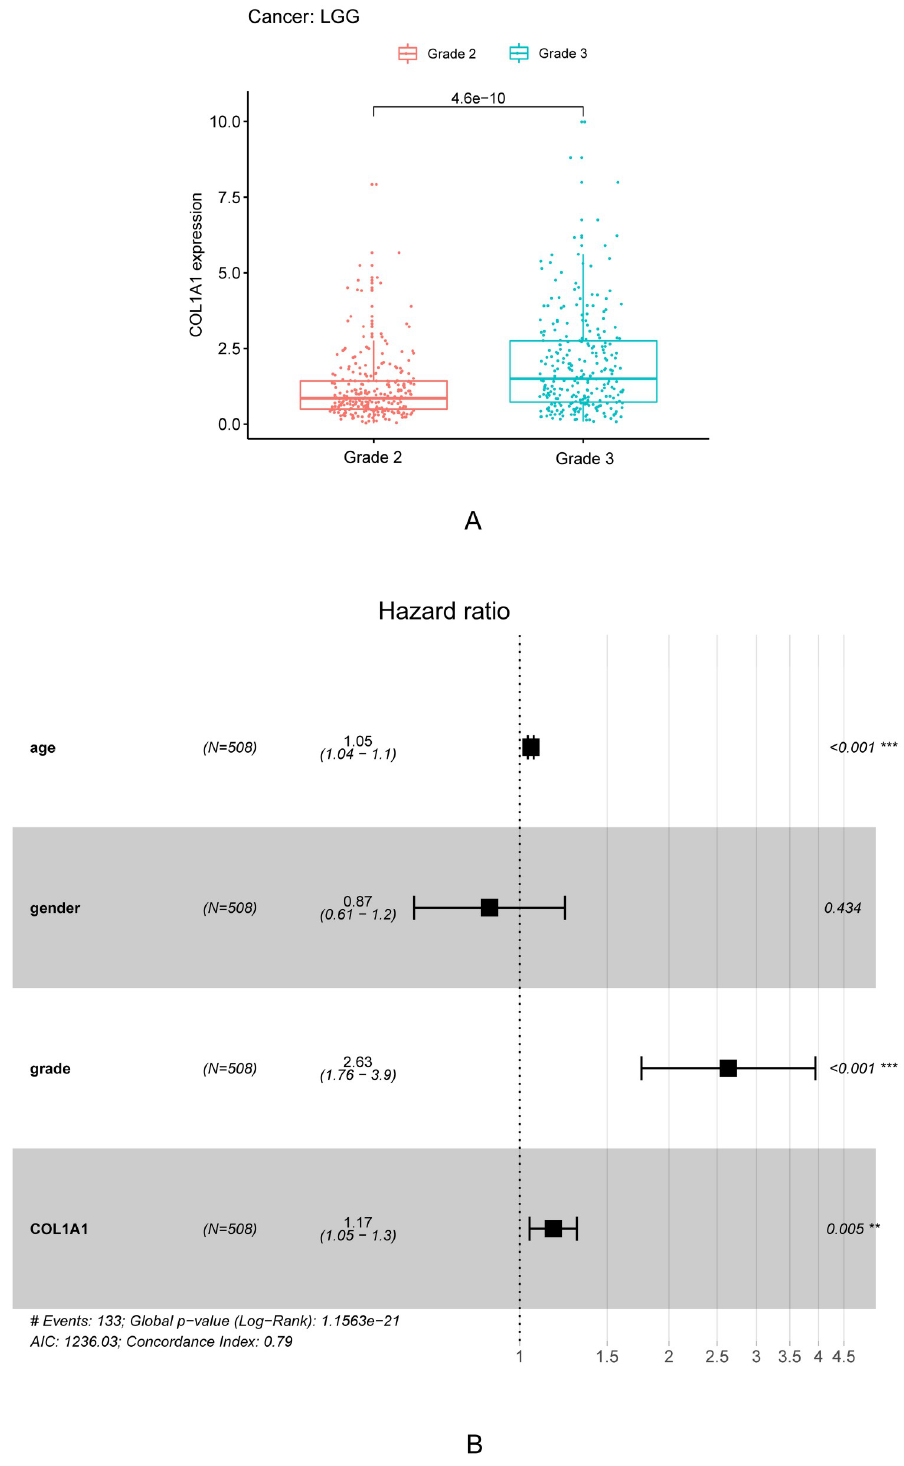
Fig 4. The expression of COL1A1 in LGG grade and the forest plot of LGG. A. Differential expression of COL1A1 in different cancer grade of LGG. Based on data from 258 grade2(G2) patients and 270 grade3(G3) patients in TCGA. B. Multivariate Cox analysis of COL1A1 expression and clinical pathological factors. As age, tumor grade and COL1A1 expression are independent prognostic factors ( � P < 0.05; �� P < 0.005; ��� P < 0.001).